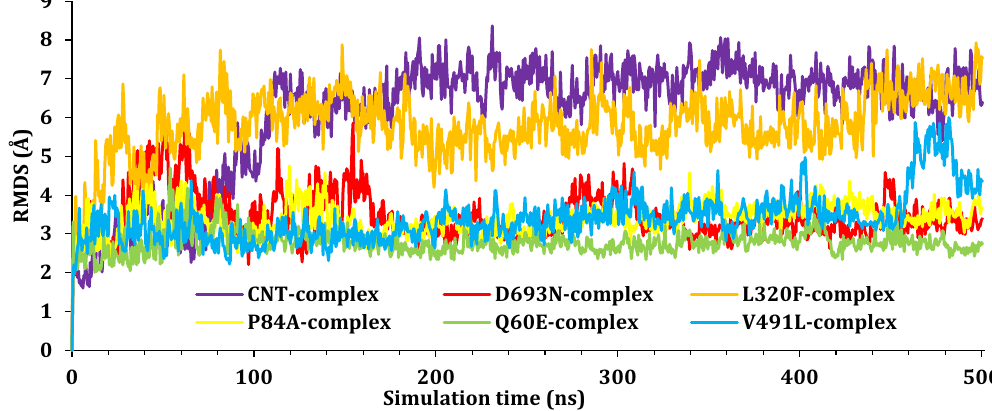
00.511.522.533.54